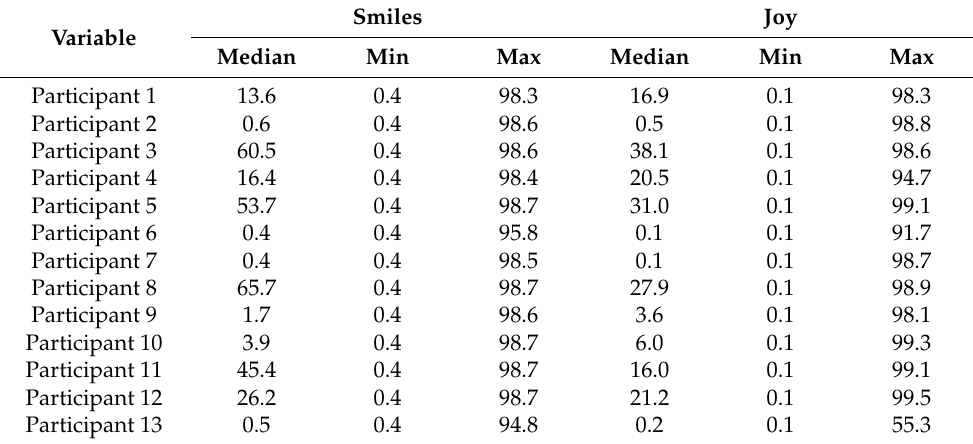
Table 1. Scores for smiles and joy.